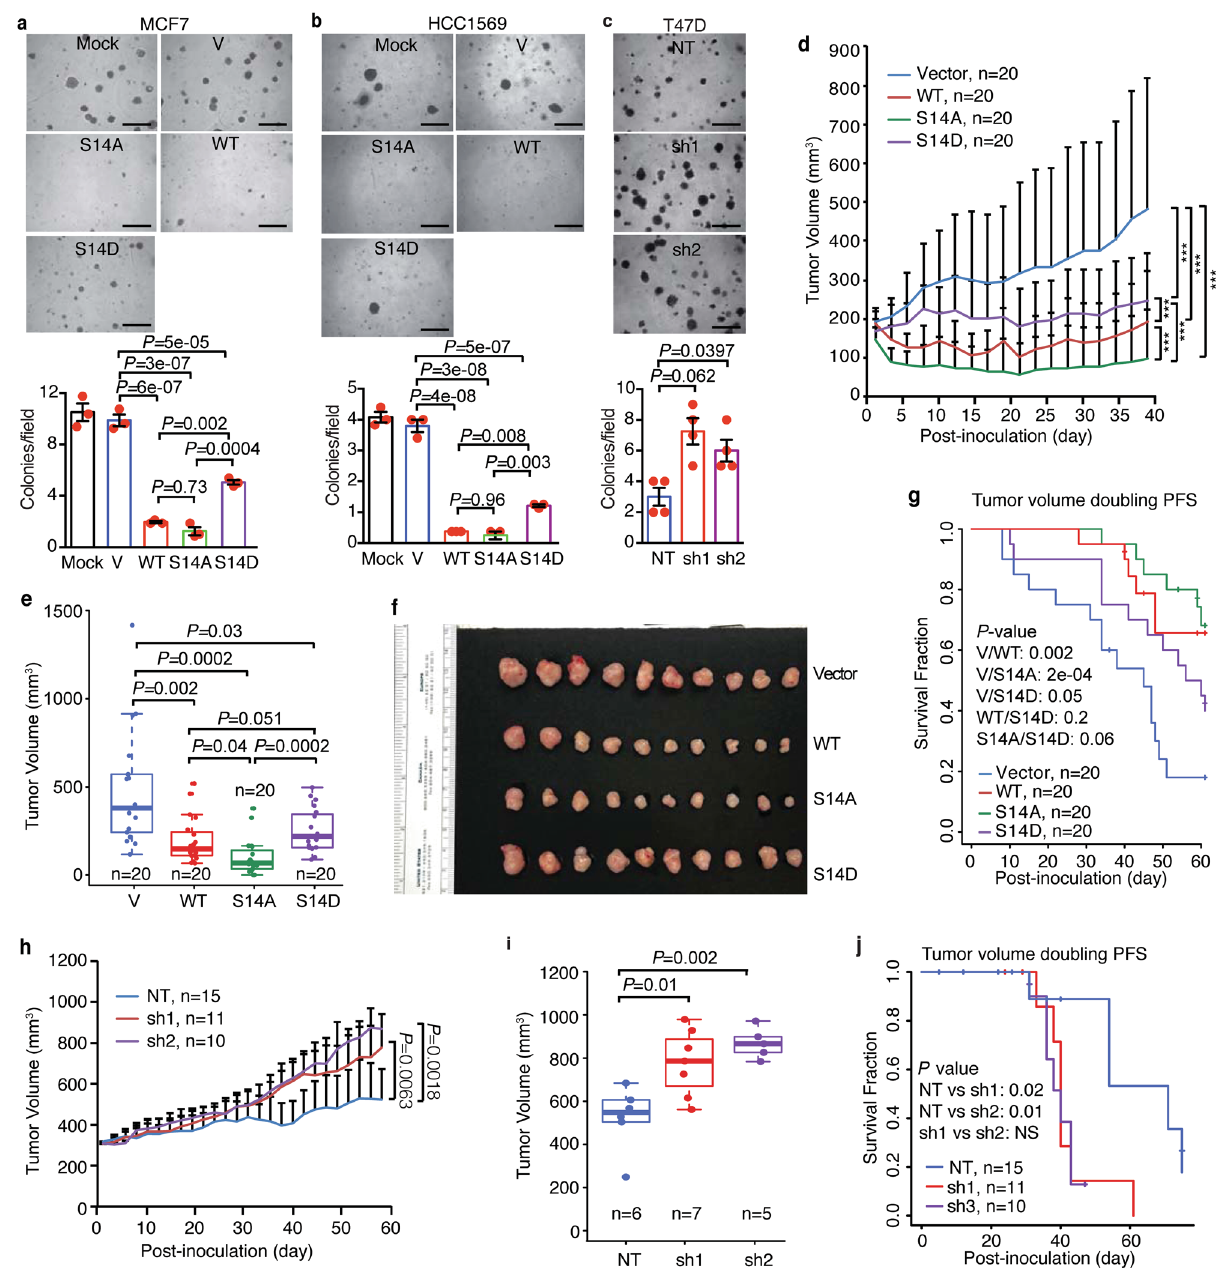
Fig. 5 RNF167-mediated ubiquitination and AKT1-mediated phosphorylation of CASTOR1 promotes breast cancer progression. a , b Weaker suppression of colony formation of ER + ( a ) and HER2 + ( b ) breast cancer cells in softagar by CASTOR1 S14D than WT and S14A. c CASTOR1 silencing enhanced colony formation in softagar of T47D cells. d – g Overexpression of CASTOR1 S14D had a less suppressive effect on breast tumor growth and a lower extended animal survival rate than WT and S14A had in a breast cancer xenograft model; the tumor volumes at the indicated time point post- inoculation were measured ( d ); the tumor volumes of the last time point were compared ( e ), and the actual tumors ( f ) and the survival rates ( g ) are shown. h – j CASTOR1 knockdown promoted tumor growth and shortened animal survival rate. The tumor volumes at the indicated time point post- inoculation were measured ( h ); and the tumor volumes of the last time point ( i ) and the survival rates ( j ) are shown. The lower panels of a – c were quanti fi cations of colony numbers from three independent experiments presented as mean ± SEM and analyzed by one-way ANOVA. For d , e , g , each mouse group contains 20 tumors ( n = 20). For h , j , the Vector control, shRNA1, and shRNA2 groups contain 15, 11, and 10 tumors, respectively ( n = 15, 11, and 10). For i , the Vector control, shRNA1, and shRNA2 group contain 6, 7, and 5 tumors, respectively ( n = 6, 7, and 5). For e , i , the boundary closest to the zero indicates the 25th percentile, a line within the box means the median, and the boundary of the box farthest from zero marks the 75th percentile. Whiskers (error bars) above and below the box indicate the minima and maxima. d , e , h , i were presented as mean ± SEM and analyzed by two-sided Student ’ s t test. g , j was analyzed by two-sided Log-rank test. “ * ” and “ *** ” denote P < 0.05 and P < 0.001, respectively. Scale bars: 200 µ M ( a – c ). Source data are provided in Source data fi